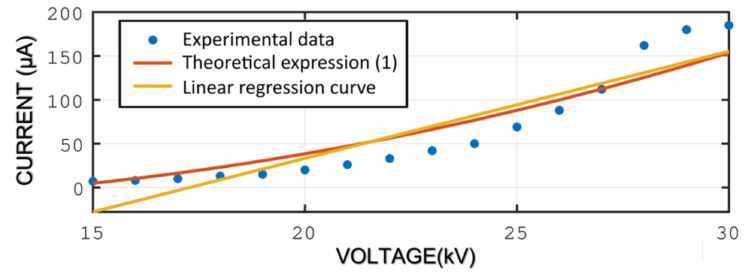
Figure 18. Comparison of the experimental results from Figure 13 for a 30 mm distance, the theoretical expression (1) and the linear regression